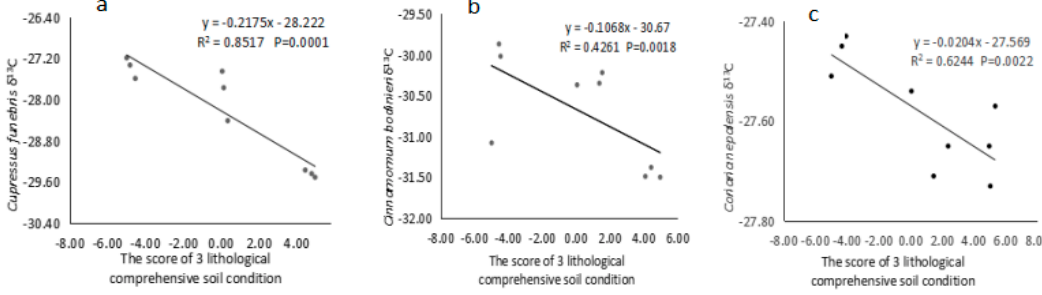
Figure 1. Relationship between the δ 13 C value in the plant leaves and the comprehensive lithological soil condition. ( a ) Cupressus funebris , ( b ) Cinnamomum bodinieri , ( c ) Coriaria nepalensis .